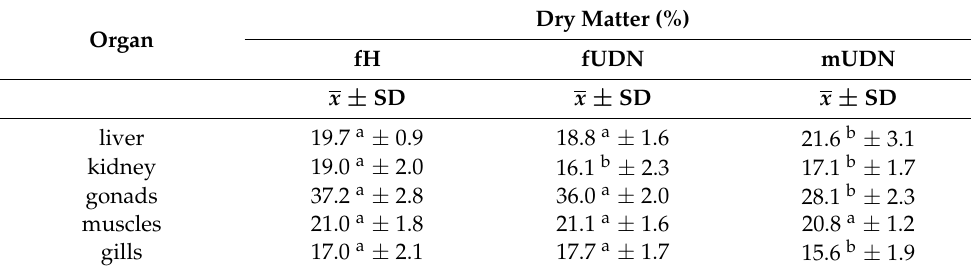
x —mean; ± SD—standard deviation; n = 20; f—female; m—male; health status: H—healthy (without UDN symptoms); UDN—with UDN symptoms; a,b values with different letters in the same row differ significantly ( p <